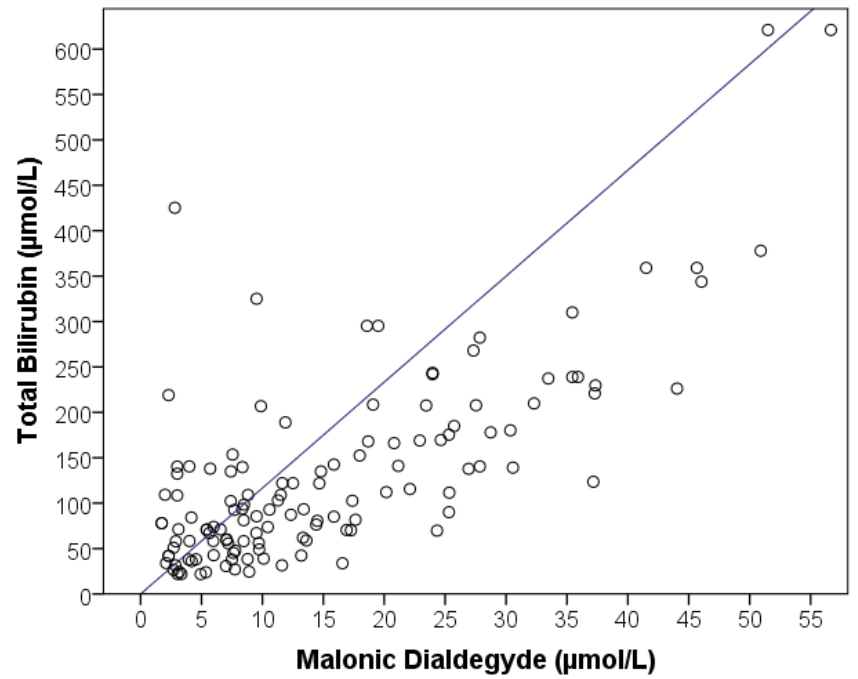
Figure 5. Correlation between the bilirubin level and concentration of MDA in blood plasma. On average, the MDA level in patients with mild hyperbilirubinemia (less than 50 µ mol/L) was 5.6 [3.2:8.8] µ mol/L, which is two-fold higher than the norm. During hospitalization of patients whose total bilirubin level was 50–100 µ mol/L, the MDA level in the blood plasma was measured at 8.4 [5.6:13.4] µ mol/L on average, which is three-fold higher than normal and 1.5-fold higher than in patients with mild hyperbilirubinemia. The MDA level in patients with a high level of total bilirubin (100–200 µ mol/L) averaged 15.9 [8.4:24.7] µ mol/L, which is 5.7-fold higher than normal. In patients with an extremely high degree of hyperbilirubinemia (above 200 µ mol/L), the MDA level was very high and averaged 32.3 [21.4:39.4] µ mol/L, which was 11.5-fold higher than normal and signifi- cantly different from all the other subgroups of patients graded according to the level of hyperbilirubinemia.